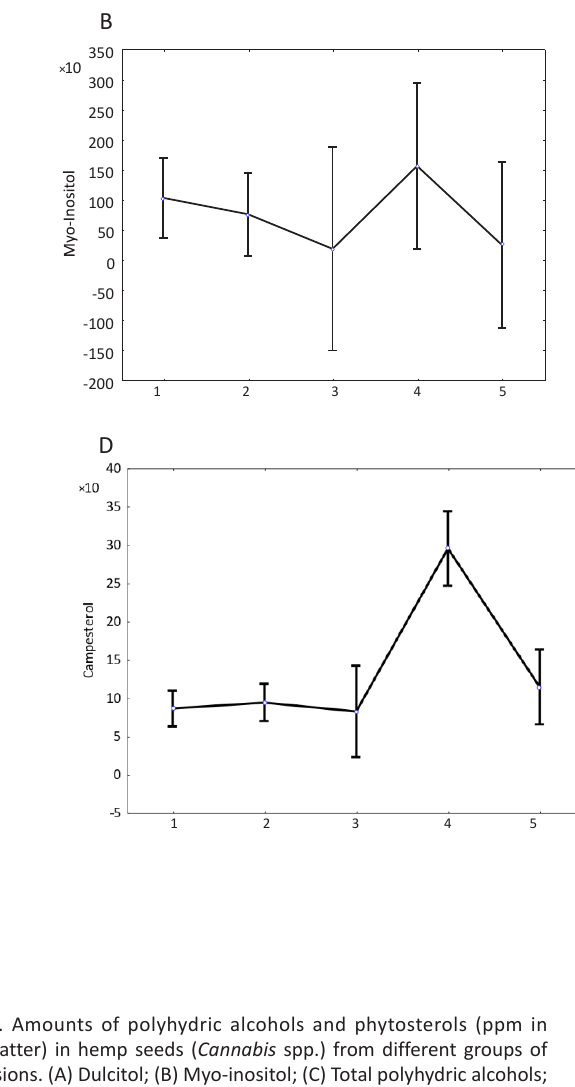
Fig. 2. Amounts of polyhydric alcohols and phytosterols (ppm in dry matter) in hemp seeds ( Cannabis spp.) from different groups of accessions. (A) Dulcitol; (B) Myo-inositol; (C) Total polyhydric alcohols; (D) Campesterol; (Е) Sitosterol. Accession designations along X-axis: (1) Feral; (2) Dual use (fibre and seed); (3) Universal (fibre, oil and seed); (4) Recreational landraces; (5) Food seed and oil (minimized seed coat/ pericarp). Means, vertical bars denote 0.95 confidence intervals. NW of Russia,